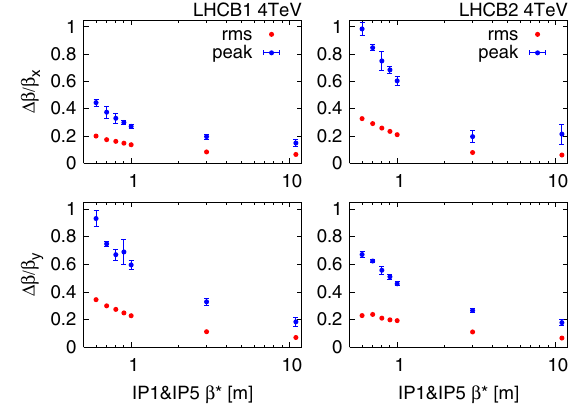
FIG. 4. (cid:1) beatingofthevirginmachinealongthesqueeze.Beam1 (left) and beam 2 (right), horizontal (top) and vertical (bottom) plots showing the peak and rms (cid:1) -beating values versus (cid:1) (cid:1) .